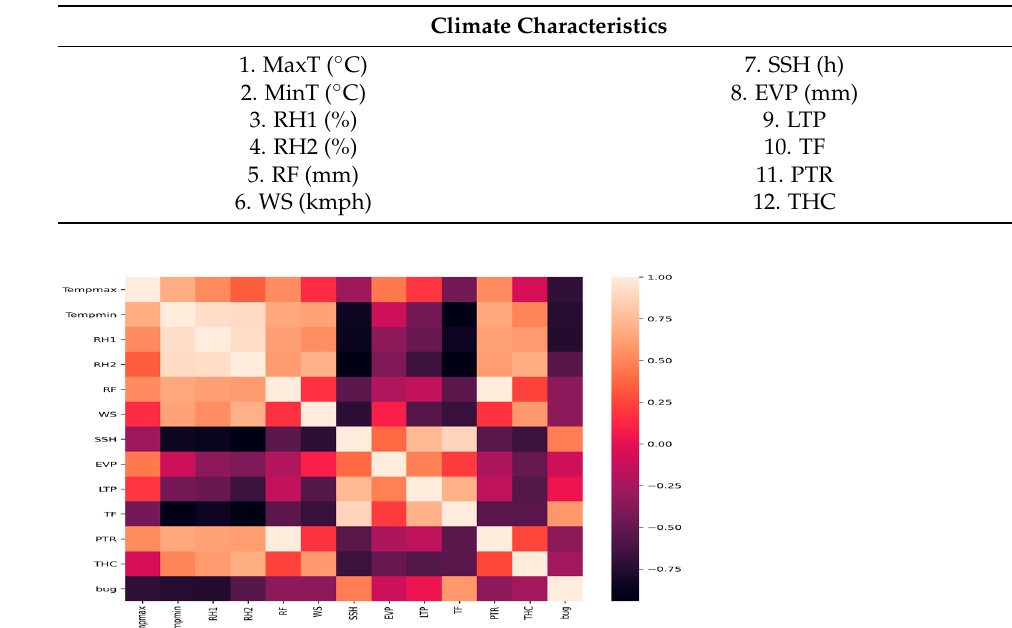
Figure 12. Heat map of the correlation coefficients in Experiment 3.